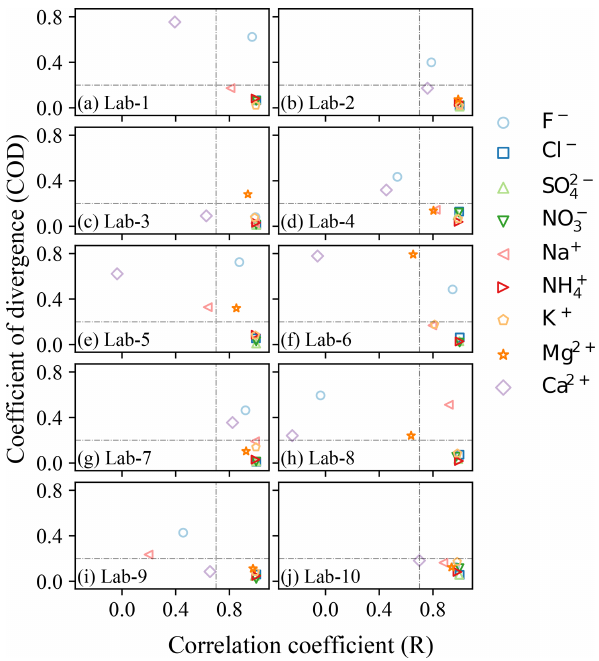
Figure 3. Coefficient of divergence (COD) plotted against correla- tion coefficient ( R ) for all ions in each lab with the median ionic concentrations of the 10 labs. (Note: vertical line indicates an R value of 0.8, and horizontal lines indicate COD values of